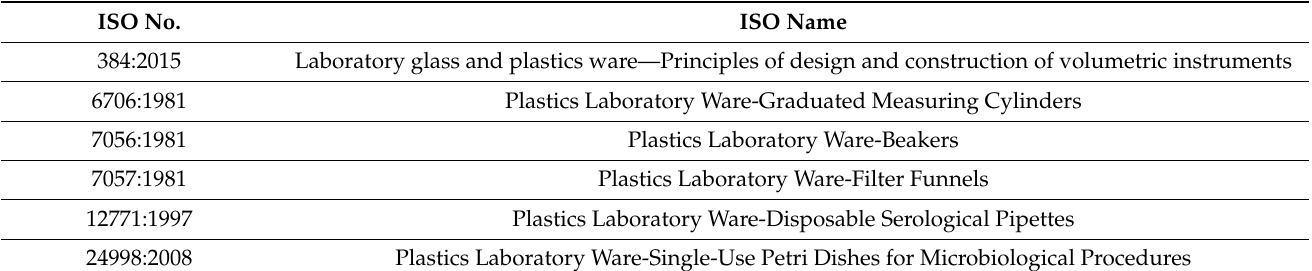
Table 13. ISO standards relating to plastic laboratory